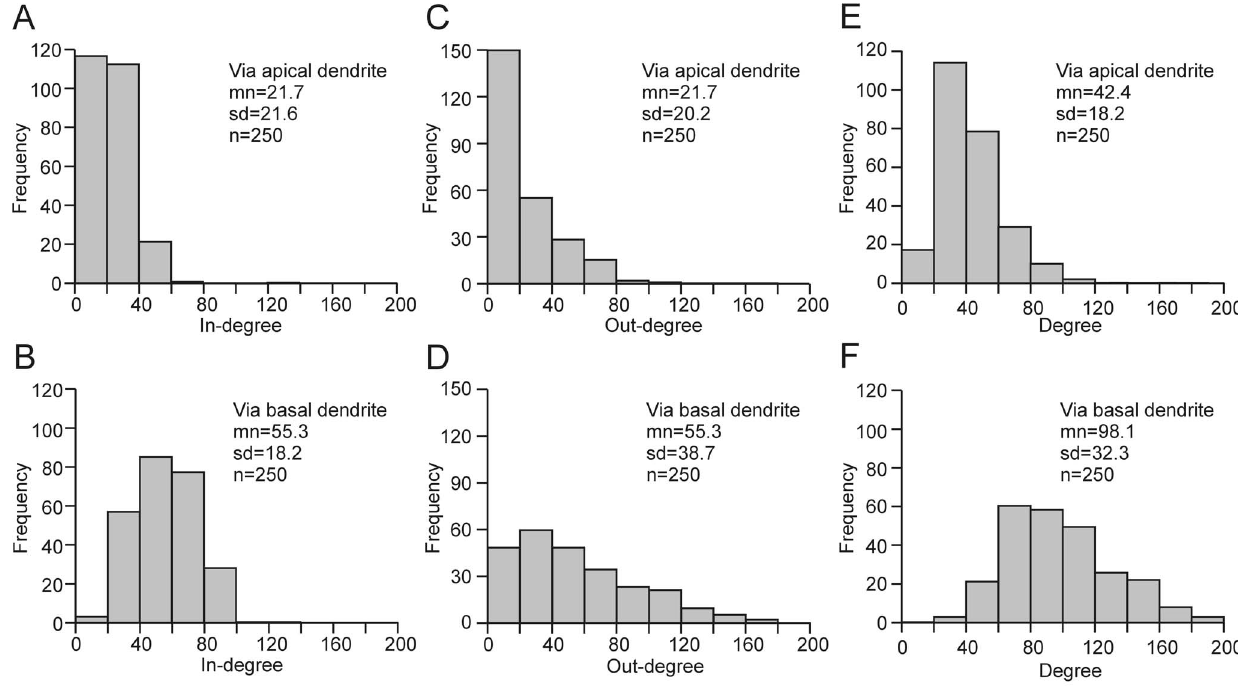
Figure 9. Frequency distributions of in-degree, out-degree and degree of neurons. A , In-degree for connections via apical dendrite. B , In-degree for connections via basal dendrite. C , Out-degree for connections via apical dendrite. D , Out-degree for connections via basal dendrite. E , Degree for connections via apical dendrite. F , Degree for connections via basal dendrite.